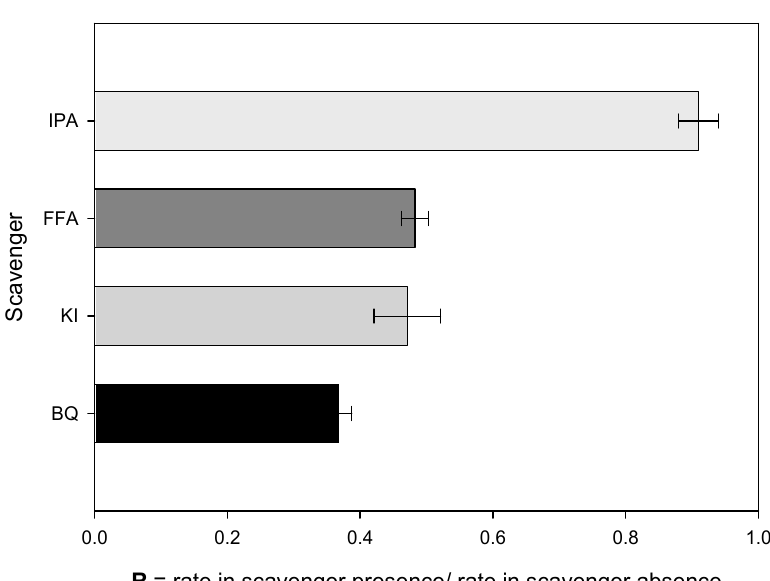
Figure 3. Effect of scavengers on the degradation of LEV. Experimental conditions: [LEV] = 13.8 µM, [IPA] = [FFA] = [KI] = [BQ] = 1.38 mM, [CdS] = 0.5 g L − 1 , UVA intensity = 40 W m − 2 , and initial pH = 5.3.